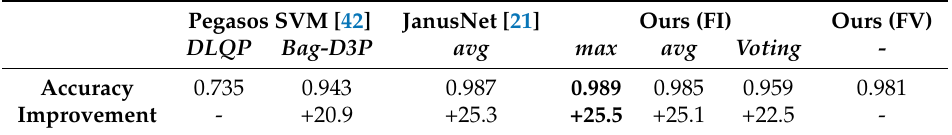
Table 4. Accuracy comparison for the face recognition task on the HRRFaceD dataset. Functions max , avg , and voting are reported in Equations (6)–(8), respectively. In the last column, we report the Face Verification (FV) accuracy of the proposed method. The higher results are in bold.